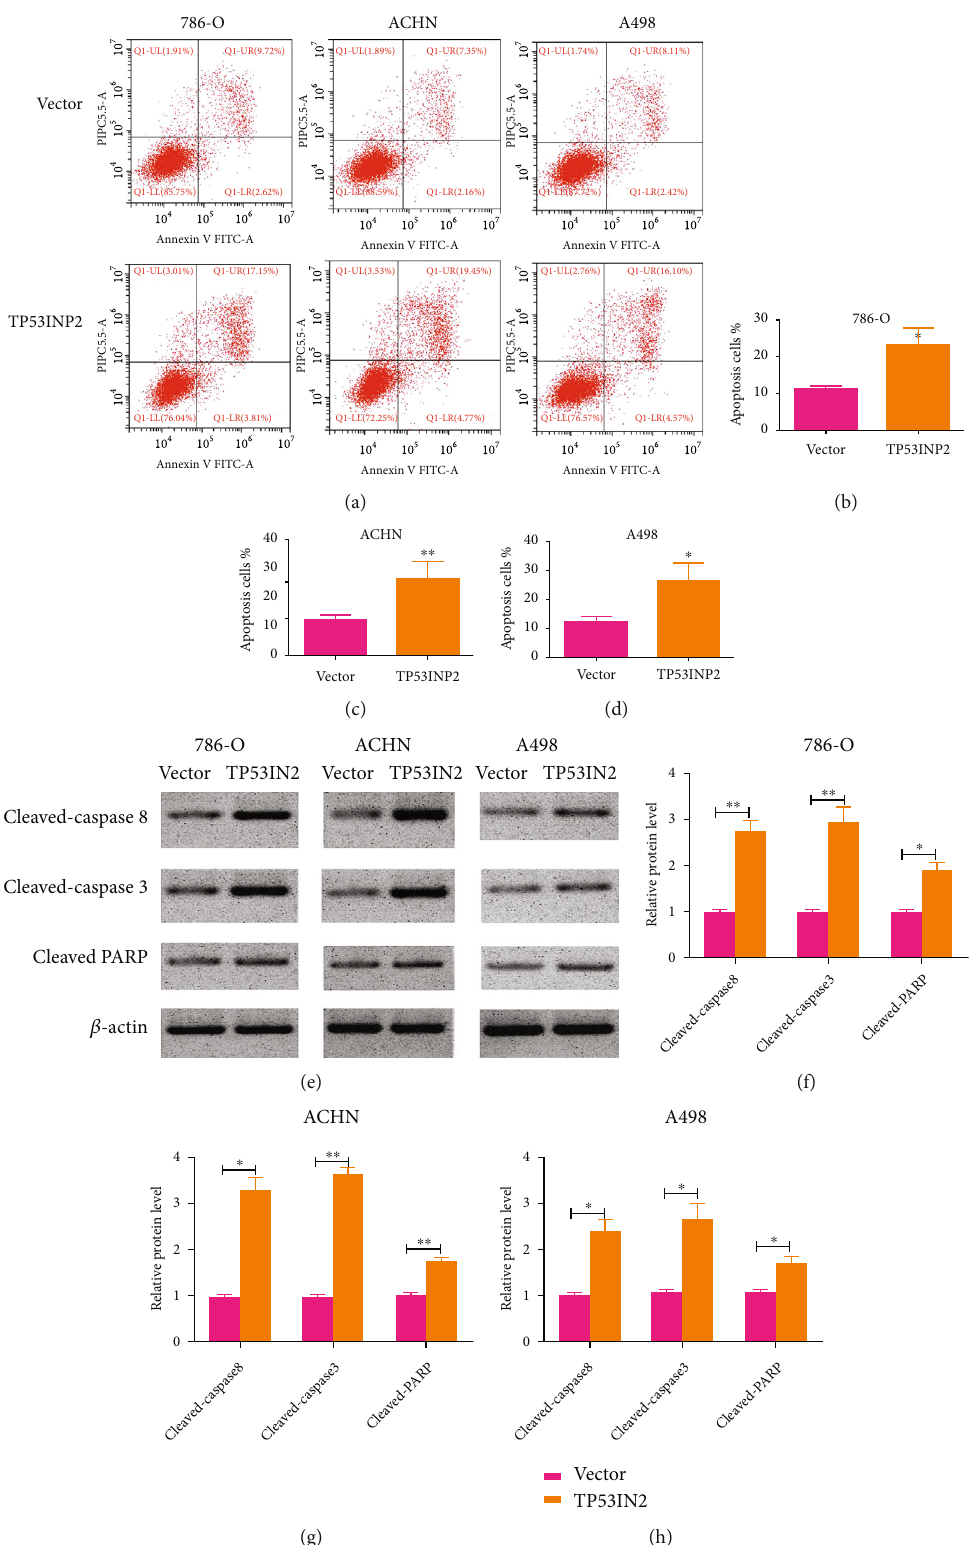
Figure 8: Overexpression of TP53INP2 promoted cell apoptosis in ccRCC cell lines. (a) – (d) Apoptosis rates of 786-O, ACHN, and A498 cell were detected by fl ow cytometry after overexpressing TP53INP2. (e) – (h) Levels of proapoptotic protein cleaved caspase-3, cleaved caspase-8, and cleaved PARP were measured by a way of western blot. Data are presented as mean ± SD of three or four independent experiments. ∗ P < 0 : 05 ; ∗∗ P < 0 : 01